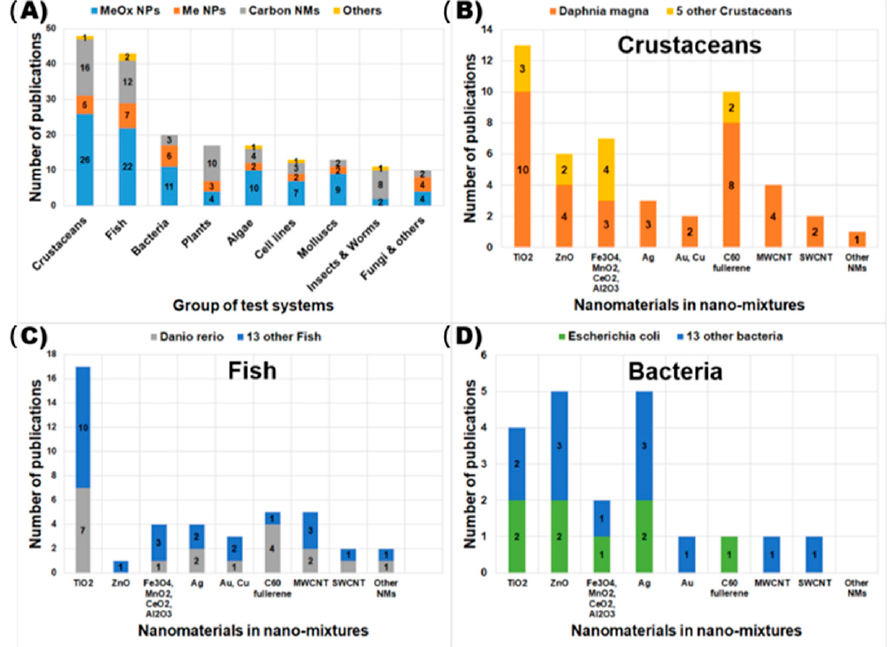
Figure 2. Number of studies on toxicity of nano-mixtures classified by group of test systems ( A ). Number of studies on toxicity of nano-mixtures classified by nanomaterials in nano-mixtures for crustaceans ( B ), fish ( C ), and bacteria ( D ). (SWCNT: single-walled carbon nanotube, MWCNT: multiple-walled carbon nanotube, NMs: